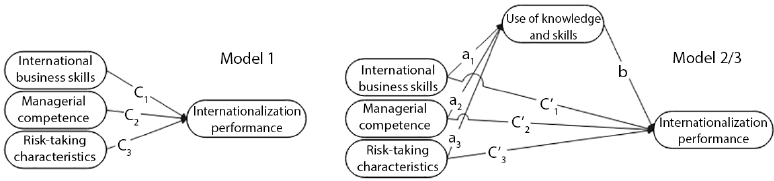
Figure 2. Decomposed conceptual model (Figure 1) referring to the OLS regression results (Table) 2 (own elaboration)